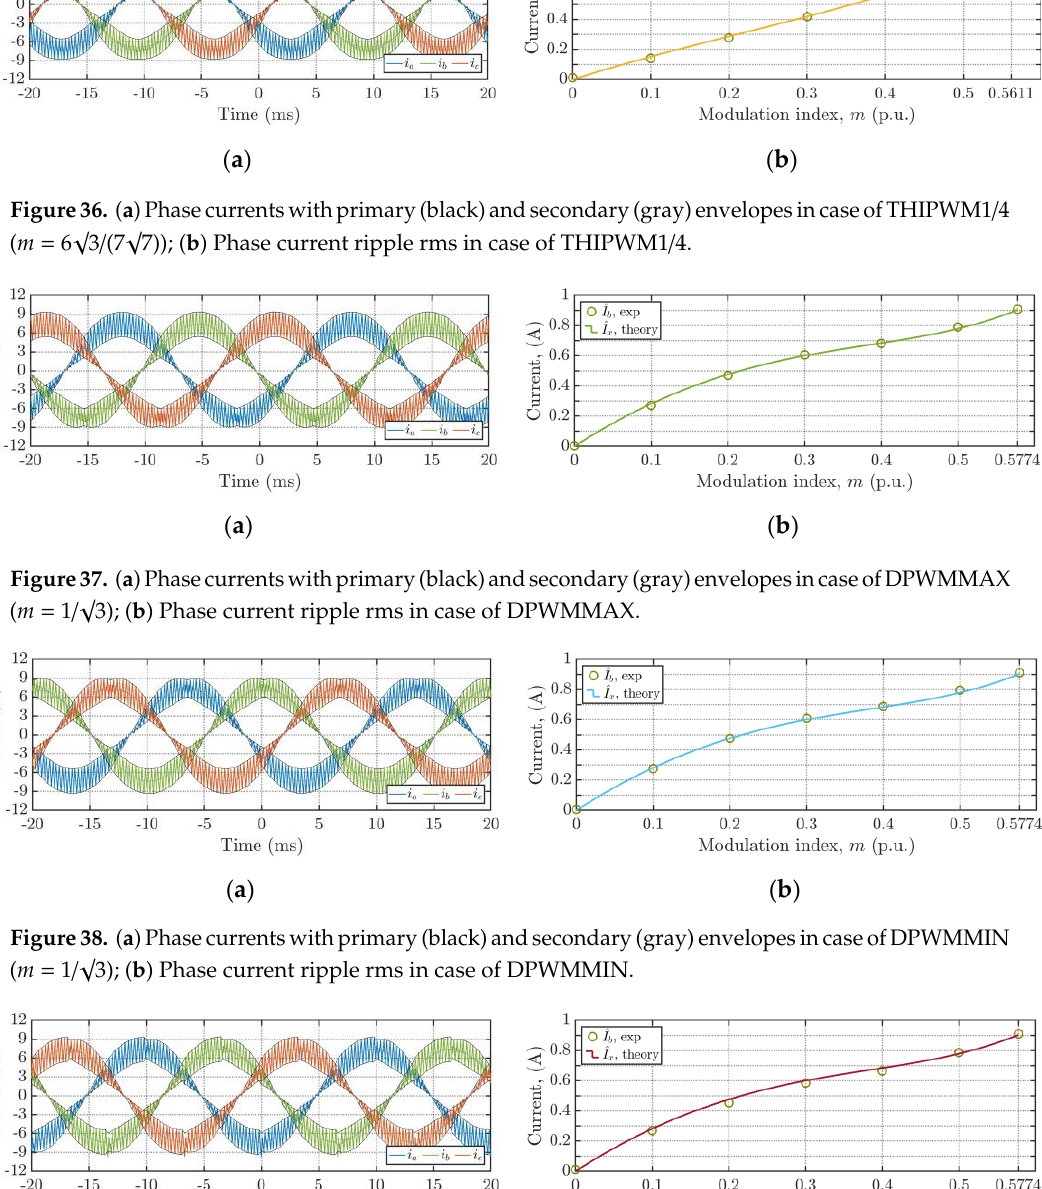
Figure 39. ( a ) Phase currents with primary (black) and secondary (gray) envelopes in case of DPWM0 √